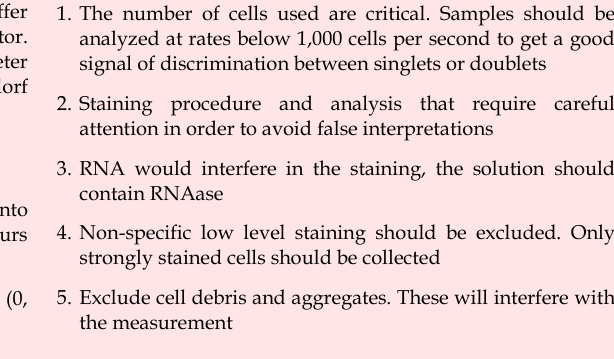
Box 1: Cell cycle analysis by flow